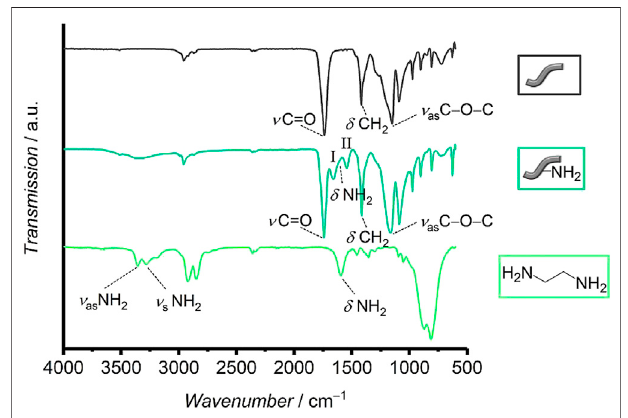
FIGURE3| Infrared spectraofunmodi fi ed and aminolyzed fi bers aswell as of ethylenediamine. In the spectrum of the aminolyzed fi bers the bands of the two amide vibrations I and II are marked.